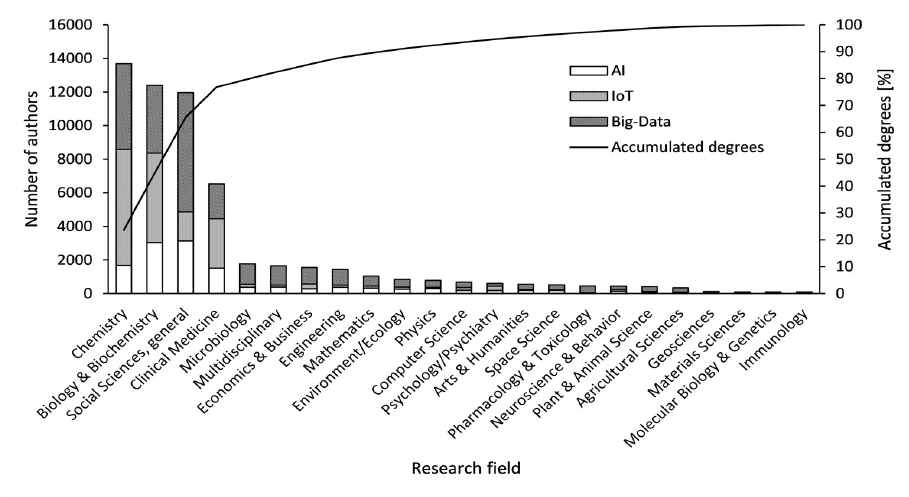
Fig 6. Specialties of authors from the top 20 countries